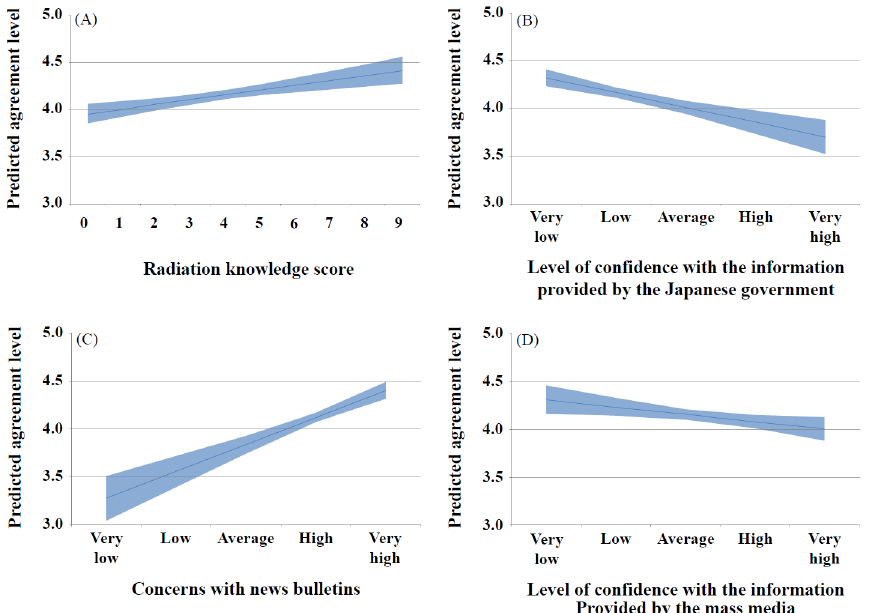
Fig 3. Changes in the agreementlevel with the maintenance of current import restraintsof Japanese seafood per radiation knowledge score, the level of confidence in the information provided by the Japanese and the level of confidence in the information provided by the mass media. The x-axis denotesradiationknowledgescore (A), level of confidencein the information providedby the Japanese government (B), concernswith the news bulletins(C), and the level of confidencein the informationprovided by the mass media (D). The y-axis shows estimates on the level of agreementof maintaining the current import restraints of Japaneseseafoodafter adjustingfor significantvariablesin the multivariatemodel. The 95% confidenceintervalon the estimates is shown in blue shading. Higherradiationknowledgescores and concernswith news bulletinswere associatedwith increasedagreementwith maintaining the current import restraints of Japaneseseafood(A, C), and higherlevels of confidencein the Japanesegovernment and the mass media were associated with the decreasedagreement with maintainingthe current import restraint levels on Japaneseseafood(B, D).